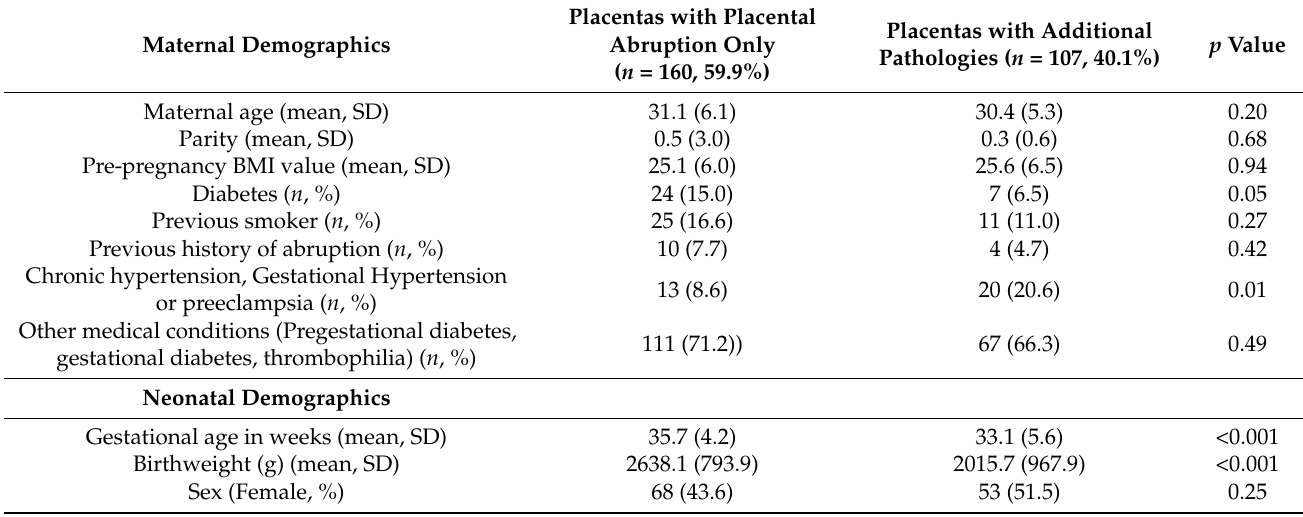
Table 1. Characteristics of the Cohorts ( n = 287).